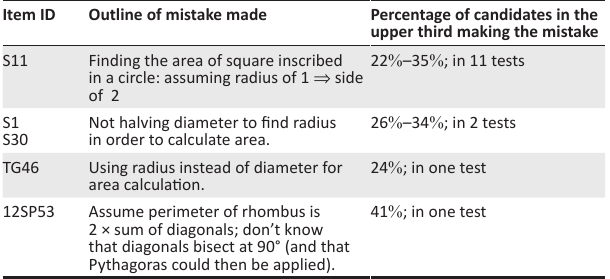
TABLE 7: Basic geometric concepts. TABLE 6: Trigonometric functions.